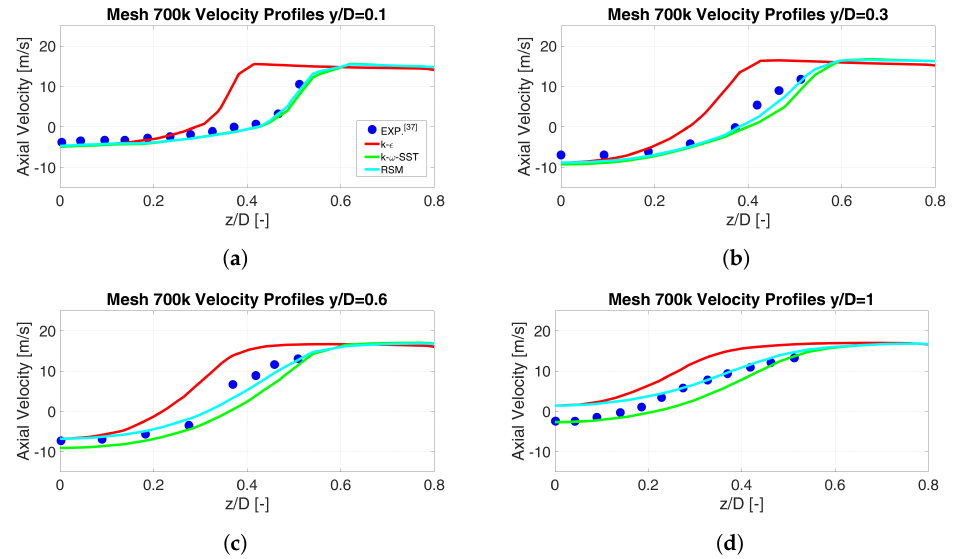
Figure 6. Study of turbulent closure: a comparison between the experimental and numerical results in terms of the axial velocity profiles for the different turbulence models ( k - ε , k - ω SST, RSM) at different axial positions (( a ) y / D = 0.1, ( b ) y / D = 0.3, ( c ) y / D = 0.6, ( d ) y / D = 1) − reacting case.